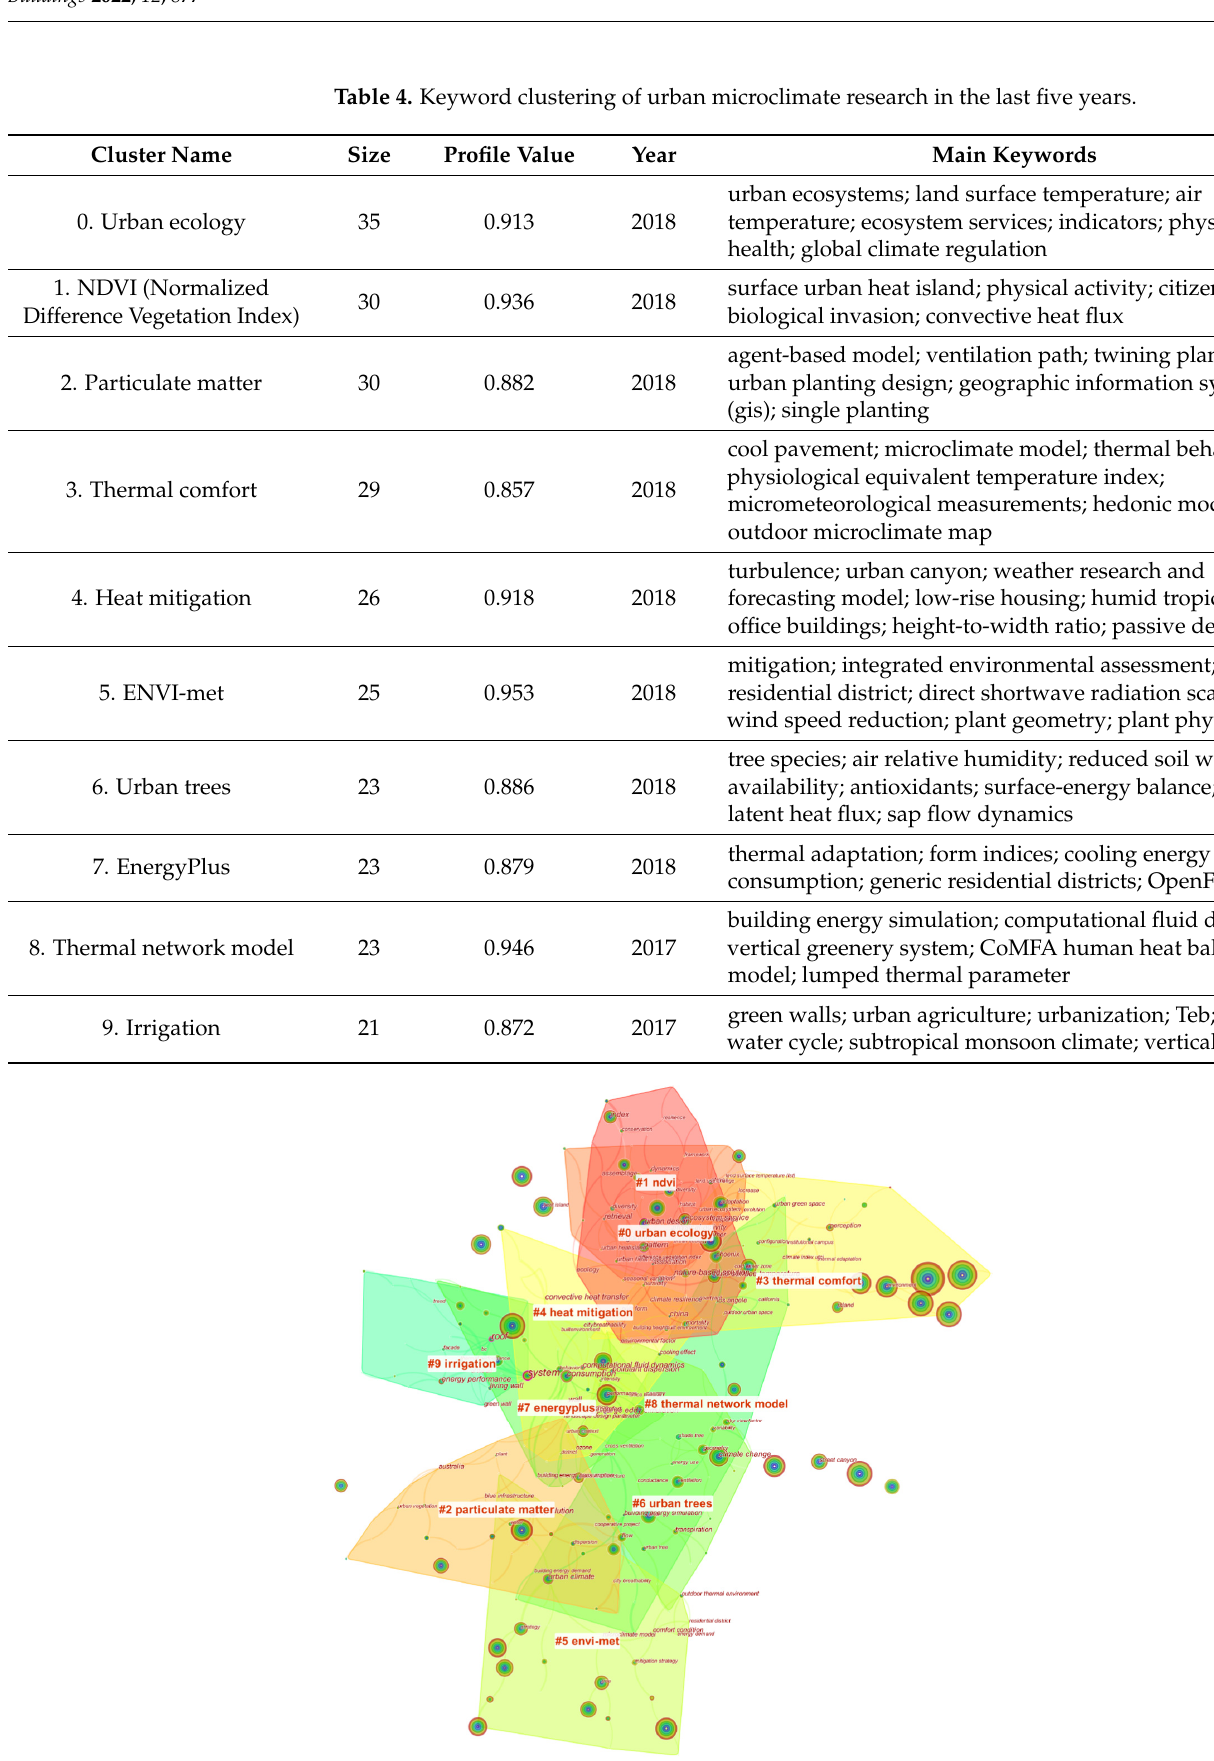
Figure 9. Cluster mapping of urban microclimate research keywords 2017–2022. Those with greater frequency (>200 times) are temperature, urban heat island, ther- mal comfort, vegetation, and environment. Those with more vital centrality (greater than or equal to 0.15) are energy-saving, cooling load, biometeorological assessment, roof, cover, and heat stress. 5. General Forecast of Trends in Research Characteristics 5.1. Multi-Scale Urban Climate Simulation Study Computer simulations can integrate the effects of different meteorological conditions on cities, buildings and humans, and play an essential role in urban microclimate assess- ment [53]. However, most studies have focused on micro-scale outdoor human thermal comfort using ENVI-met, and more multi-scale model coupling is needed at the urban level [54], e.g., the high-resolution urban climate model PALM-4U [55], and the urban multi-scale environmental predictor UMEP [56]. Future research could combine models at different scales with climate zones, and there are already nesting ENVI-met into local climate zones LCZ [57], WUDAPT [58], mesoscale models (e.g., WRF), or larger scale model domains [57], intending to achieve more scientific strategic plans for cities to im- plement climate change.